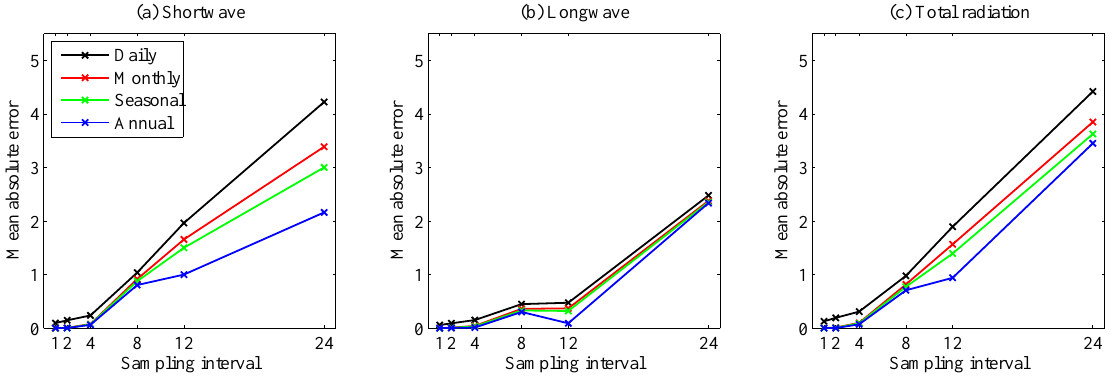
Figure 9. As for Figure 7, ( a ) shortwave; ( b ) longwave and ( c ) total radiation, but showing δ r , n